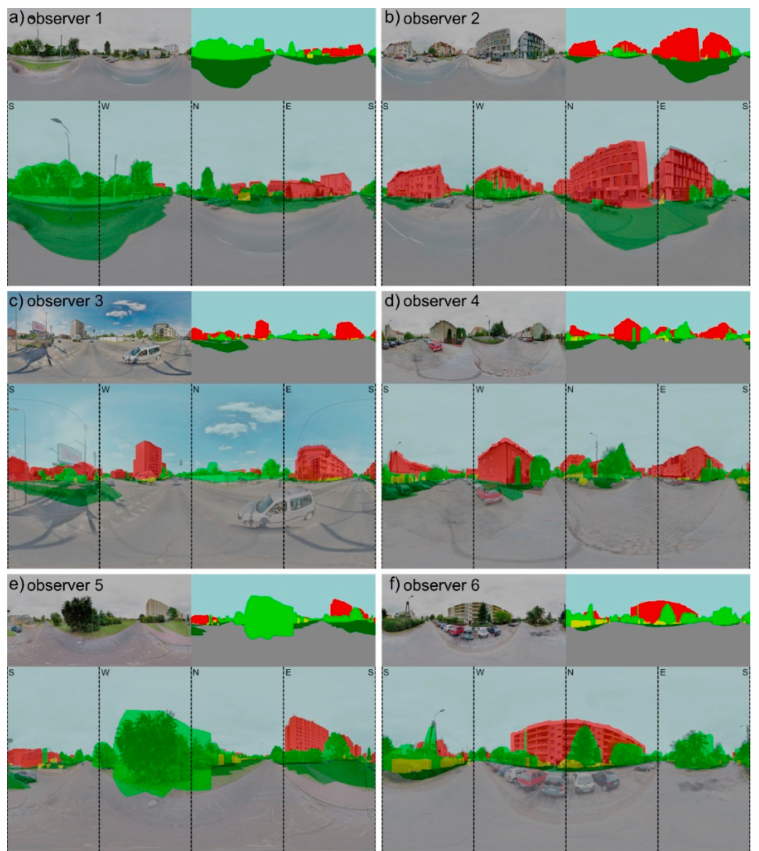
Figure 4. Comparison between Google Street View (GSV) images and panoramic renders for observers 1–6 ( a – f ); GSV image (top right corner), rendered panoramic image (top left corner), GSV and rendered panoramic image overlaid with 50% transparency (bottom).